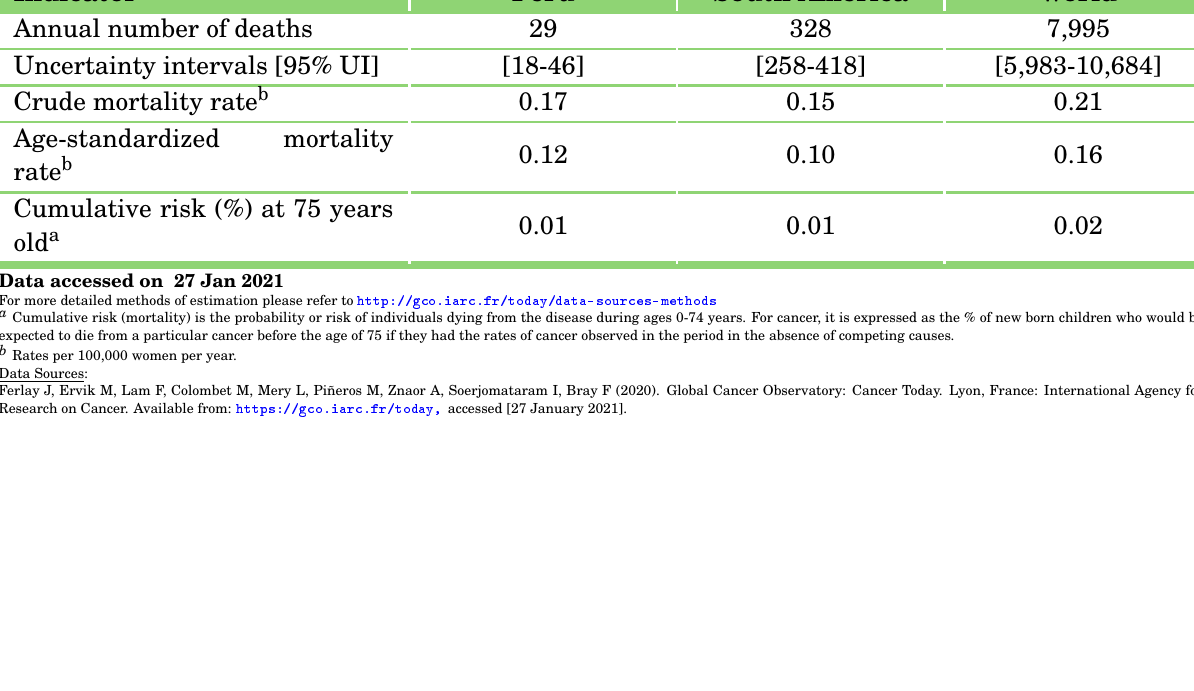
Table 12: Vaginal cancer mortality in Peru (estimates for 2020) Indicator Peru South